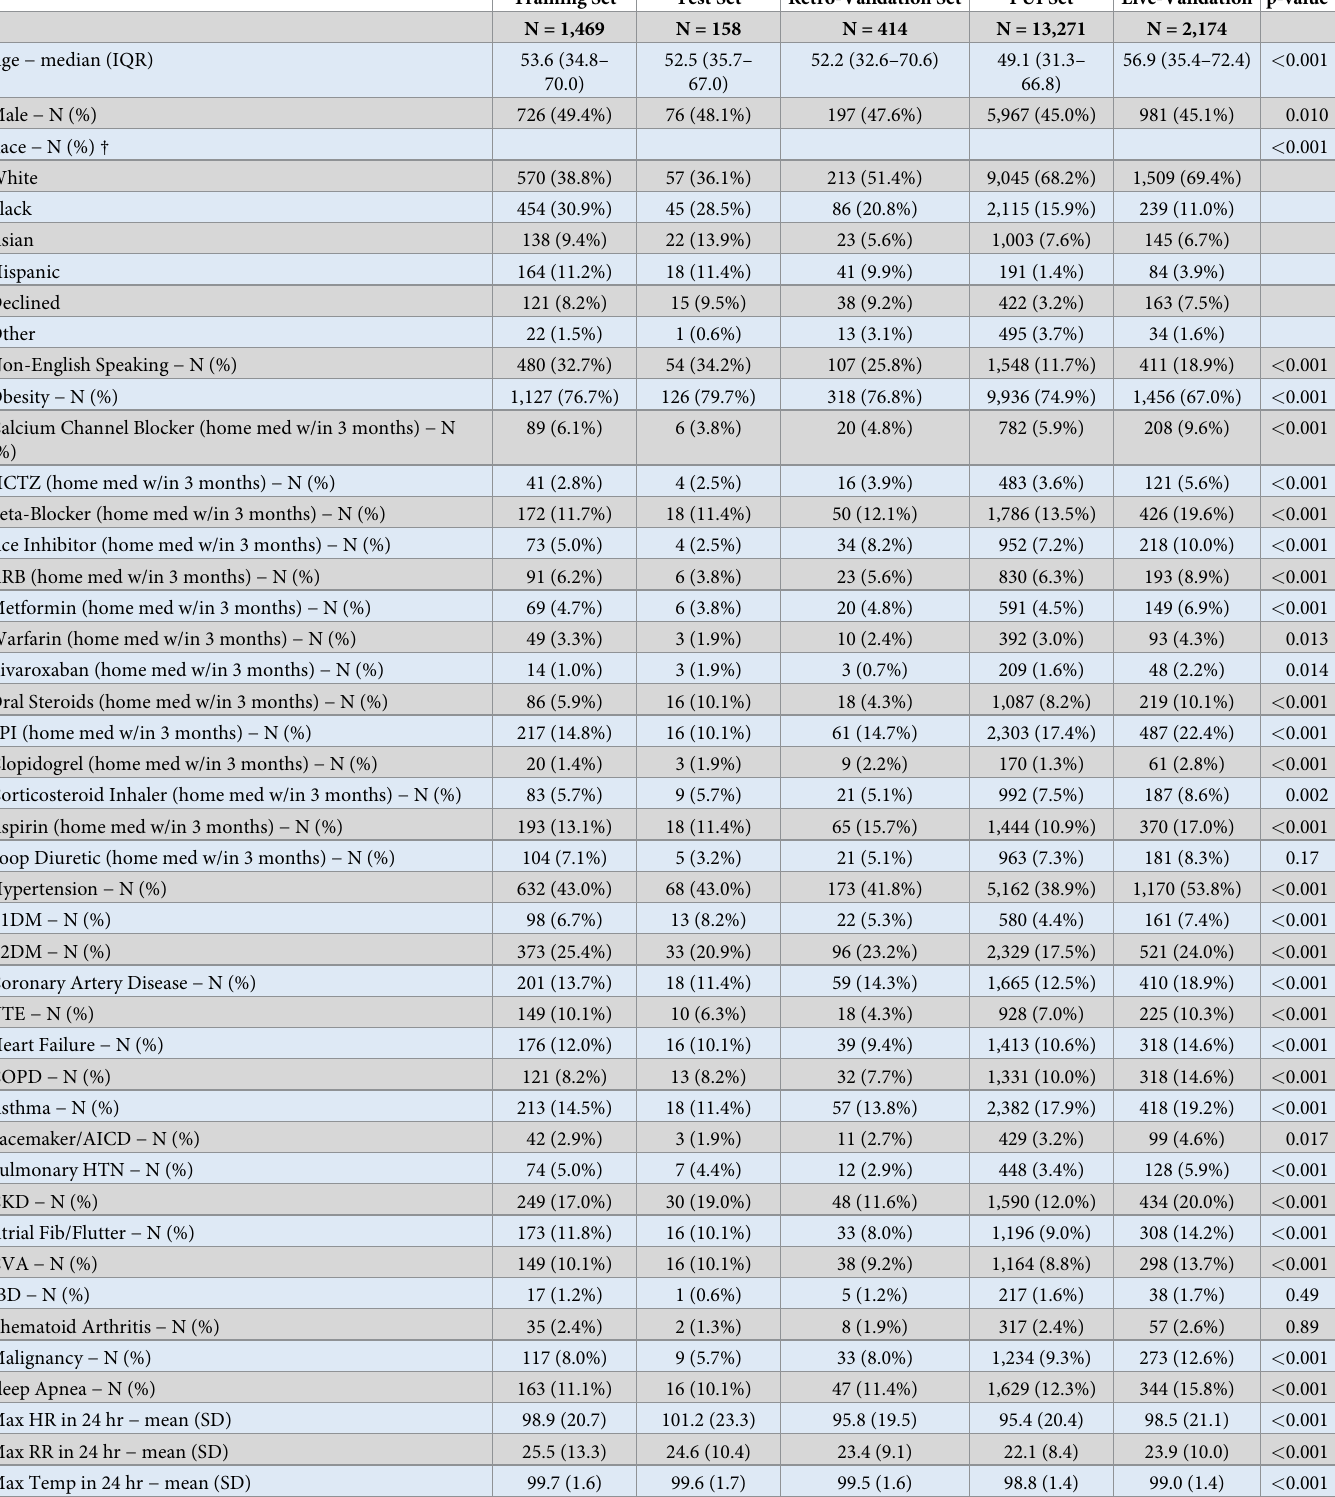
Table 1. Characteristics of the patients included in a training set, temporal validation set, PUI set, and real-time validation